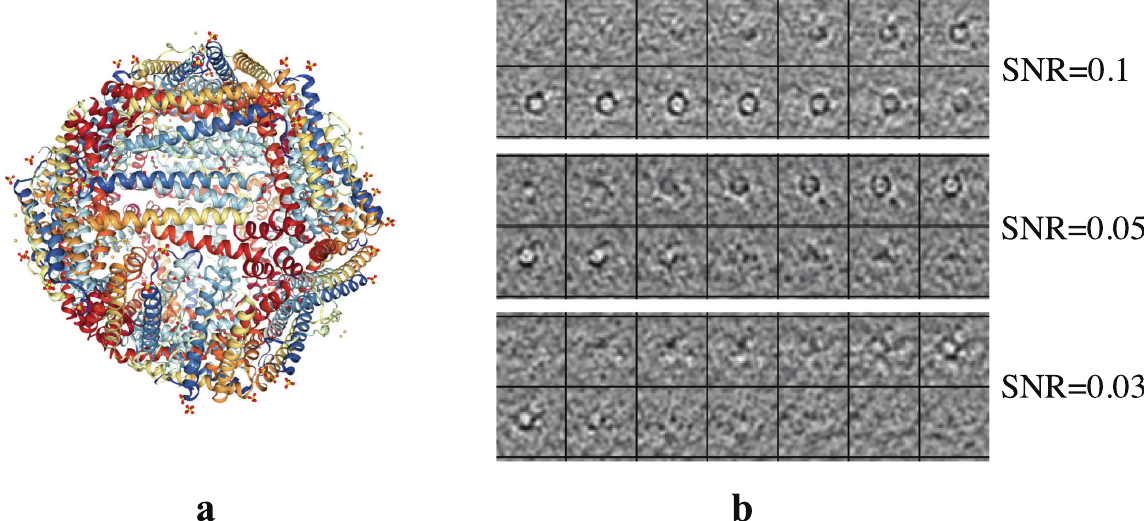
Data Bank [22]. Different noise were added to achieve different SNR levels and the particles are randomly rotated and translated. In this paper, we chose three SNR levels that are similar to the real subtomograms including 0.03, 0.05 and 0.1 to make three simulated datasets. And for each dataset, we randomly selected 100 subtomograms for each complex and 100 subtomo- grams containing no macromolecule as the 23rd class. An example of the simulated dataset is shown in Fig 2.